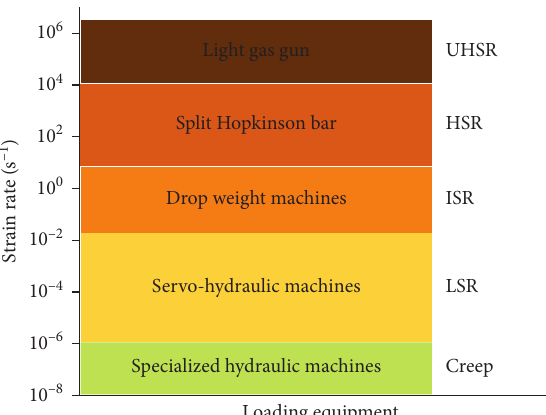
Figure 1: Classification of strain rate and loading